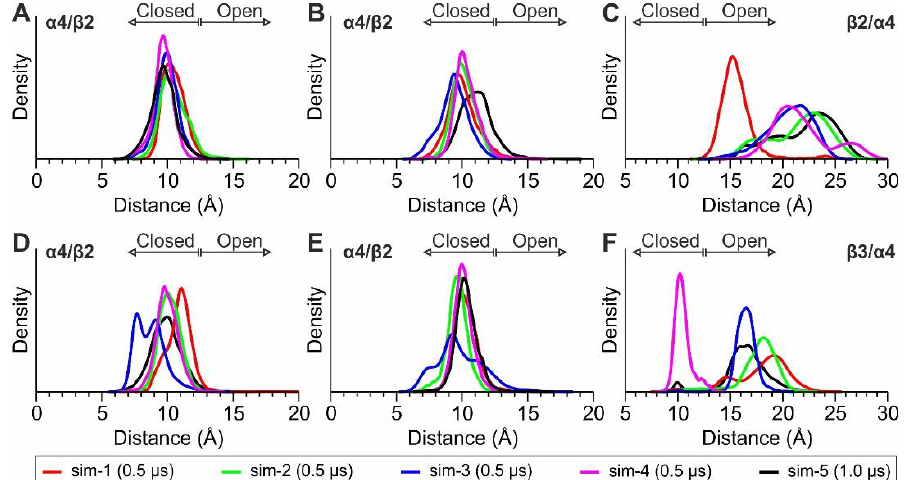
Figure 3. Distributions of loop C distances extracted from the MD simulations of the (α4) 2 (β2) 3 nAChR ( A – C ), and the corresponding distributions from the (α4β2) 2 β3 nAChR ( D – F ). Panels ( A , B ) and ( D , E ) are from the two α4(+)/β2(+) interfaces of each subtype, whereas panels ( C ) and ( F ) are from the β2(+)/α4(−) and β3(+)/α4(−) interfaces, respectively. Loop C distances are as defined in Figure 2C and the probability density functions were calculated using the kernel estimator in R.